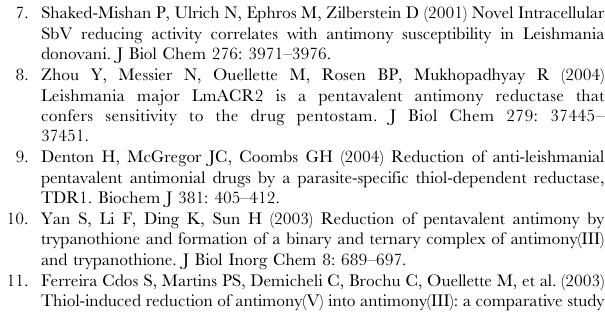
Table S3 Genes significantly modulated in antimony-resistant Leishmania amazonensis Ba199Sb III 2700.3. The data were obtained by full genome microarray hybridization of Ba199Sb III